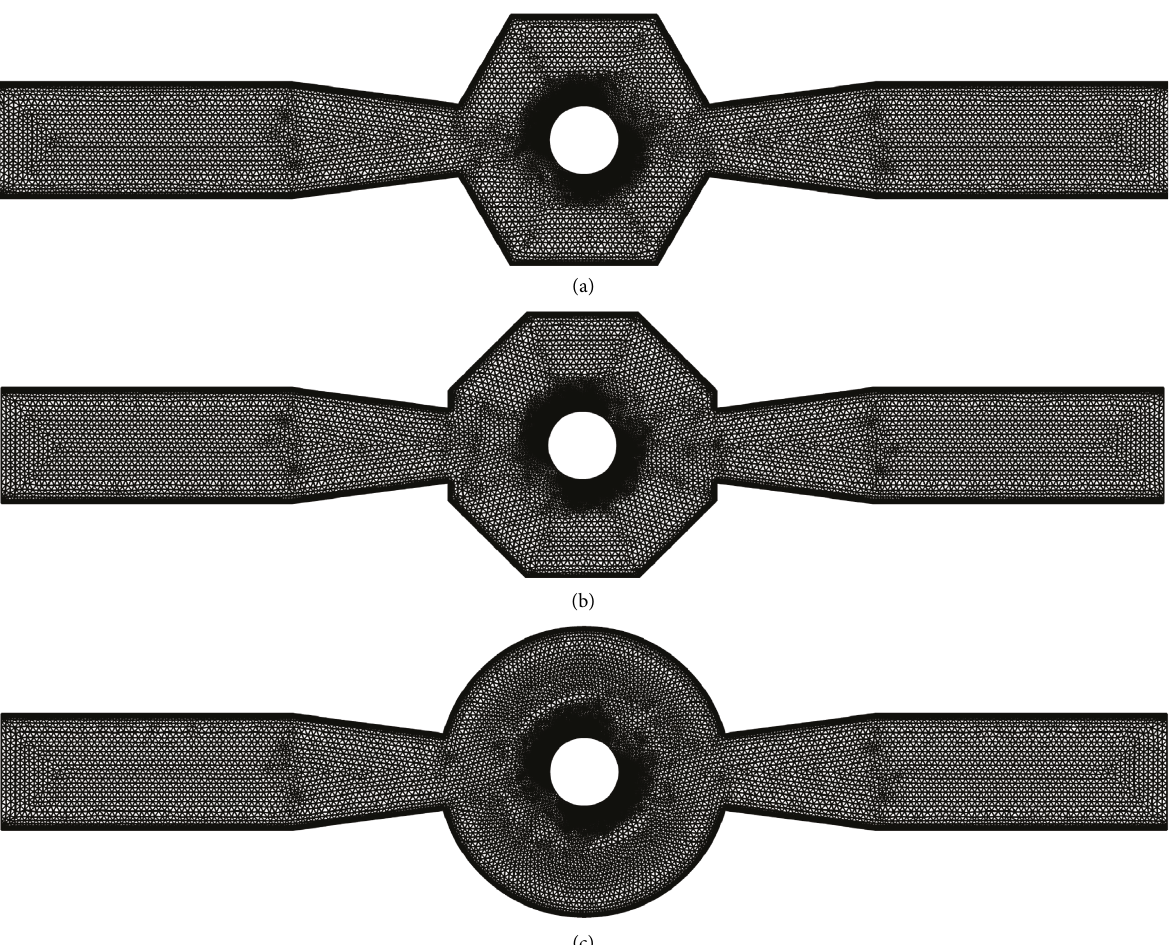
Figure 3: Meshing of micromixer mixing chambers: (a) hexagonal; (b) octagonal; and (c) circular.